Question: Produce a descriptive caption suitable for publication.
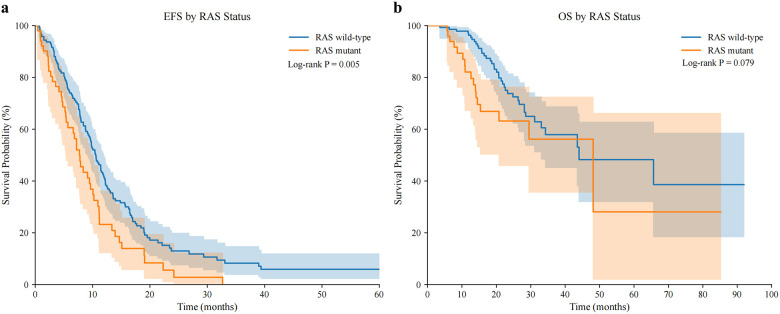
Answer: Comparison of event-free survival (EFS) and overall survival (OS) between RAS-mutant and wild-type CRLM patients. ( a ) EFS by RAS status. ( b ) OS by RAS status.